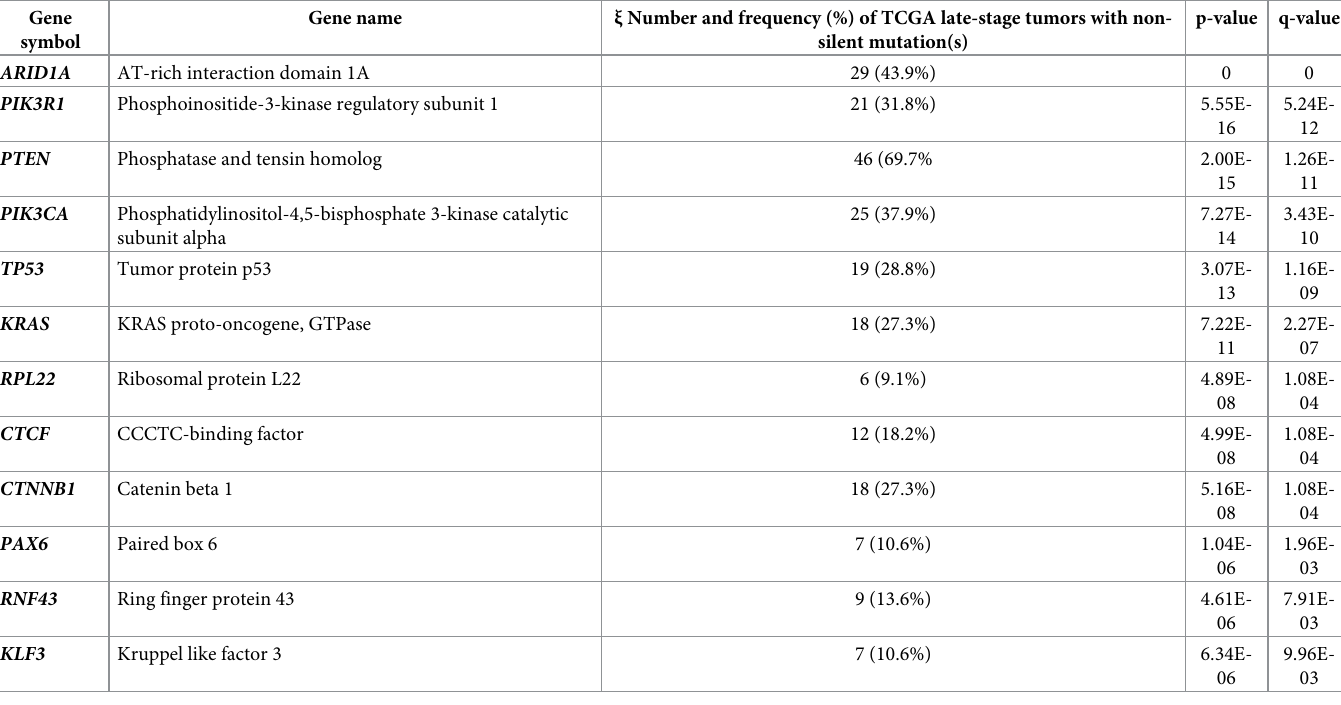
Table 2. SMGs (q � 0.10) identified among 66 late-stage TCGA